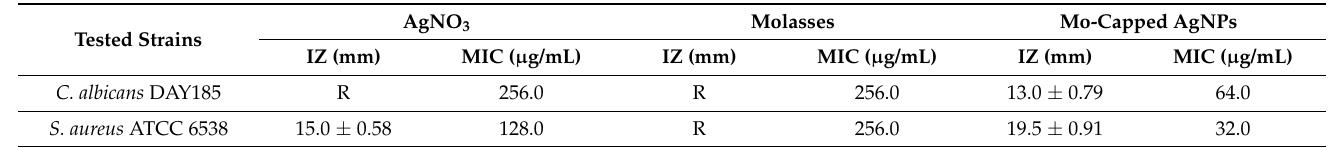
Figure 2. UV–vis spectroscopy of the prepared Mo-capped AgNPs. Table 2. Antimicrobial activity of the synthesized AgNPs.